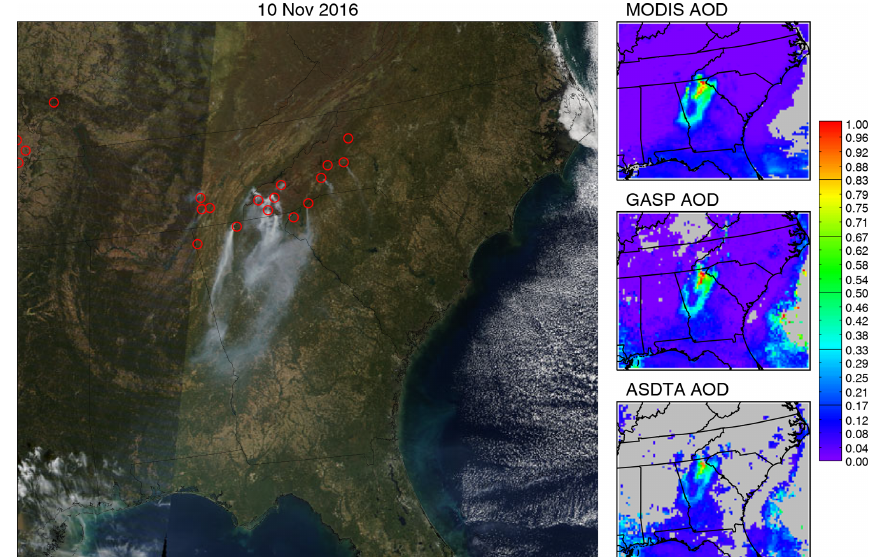
Figure 2. Detection of fires over the southeastern region of the United States on 10 November 2016. True-color images from MODIS (left), MODIS AOD (top right), GASP AOD (middle right), and ASDTA AOD (bottom right) are shown. MODIS true-color images and AOD are obtained from https://earthdata.nasa.gov/ (last access: 29 August 2020), and GASP and ASDTA AOD are obtained from NOAA NESDIS.